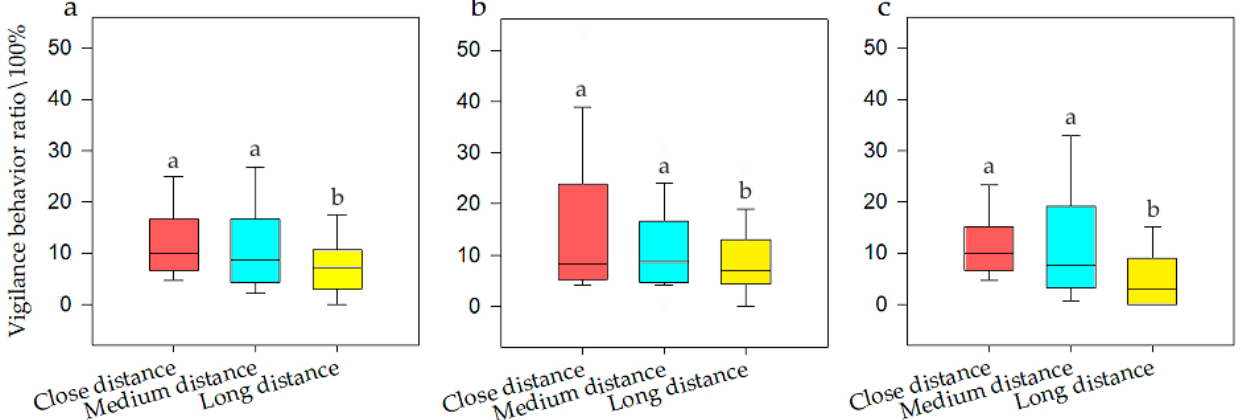
Figure 4. Vigilance behavior of bean geese (( a ) Population N; ( b ) Population N1; ( c ) Population N 2 ) of close distance, medium distance, and long distance. Different letters in the graphs represent significant differences from one-way ANOVA and SNK tests. Bars represent means; error bars denote standard deviations. The bar with the highest vigilance behavior ratio is marked as “a”. The vigilance behavior ratio is compared with other interference distances, and the difference is significant, marked as “b”.